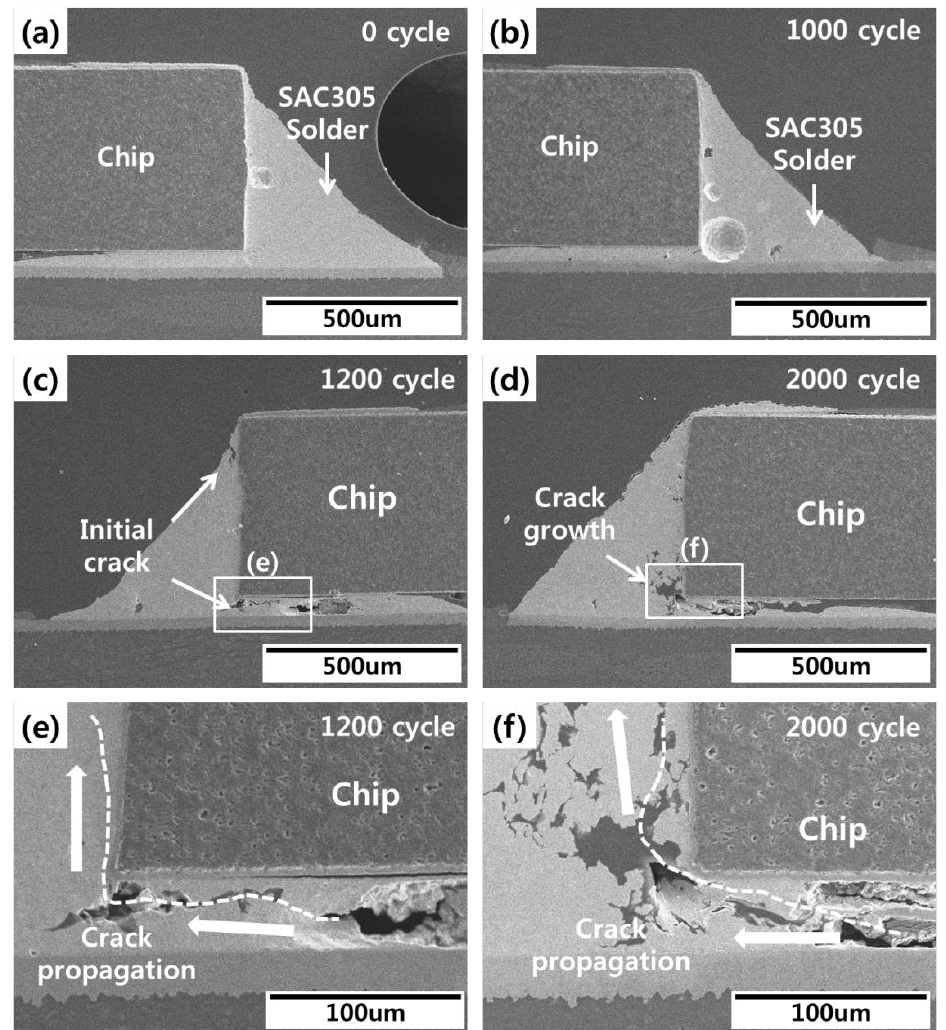
Figure 9. Conventional SAC305 solder joint images during thermal shock testing: ( a ) 0 cycles, ( b ) 1000 cycles, ( c ) 1200 cycles, ( d ) 2000 cycles, ( e ) enlarged image of the initial crack, and ( f ) enlarged image of the crack.